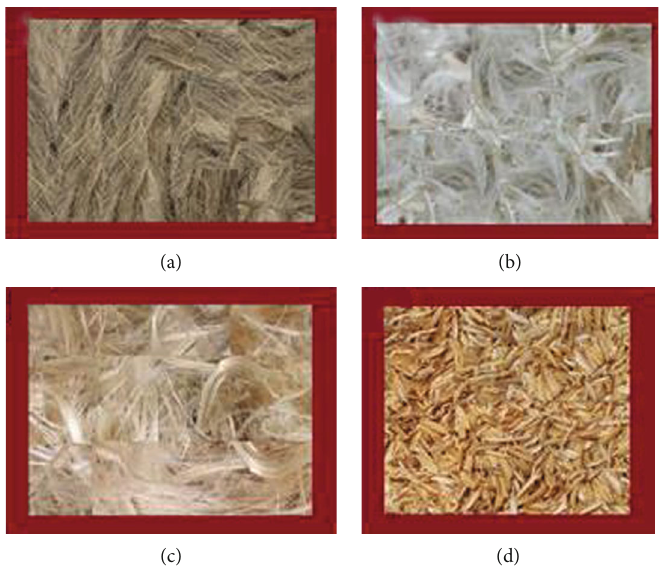
Figure 1: Natural fi bers: (a) fl ax fi ber, (b) chicken feather fi ber, (c) kenaf fi ber, and rice husk fi ber. Table 2: Summary of fl exural strength and in fl uence of input parameters.